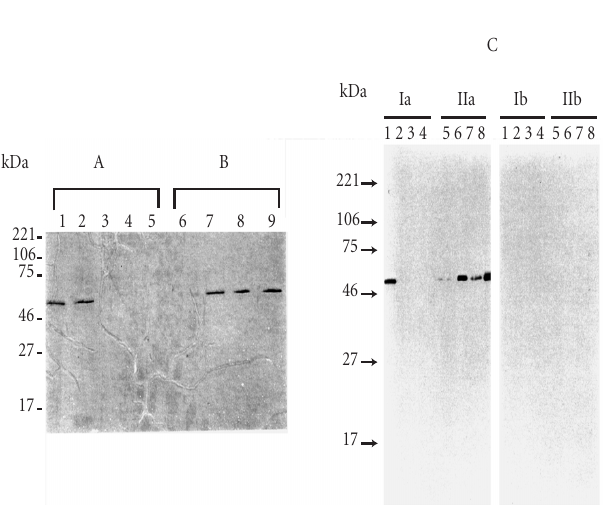
Figure 1: (A) Elution profiles of T. cruzi Tc52-bound to S-hexyl glutathione columns with either S-hexyl glutathione (1) or the fol- lowing amino acids: L-cysteine (2), L-methionine (3), L-glycine (4), glutamic acid (5). (B) After elution as described in A, the columns from which the eluates analysed in lanes 2, 3, 4, and 5 were recov- ered, washed with the column buffer, and loaded with the same buffer containing S-hexyl glutathione, the corresponding eluates were analysed in lanes 6, 7, 8, and 9, respectively. As shown in lane 6, residual Tc52 could be recovered from the column which was first loaded with L-cysteine (lane 2). In contrast, Tc52 which still bound to the glutathione matrix after the elution with L-methionine (3), L-glycine (4) or Glutamic acid (5), could be efficiently eluted by S-hexyl glutathione (lanes 7, 8, 9, respectively). (C) Aliquots of the eluted samples in A (Ia) and B (IIa) (the lanes 1, 2, 3, 4, 5, 6, 7, and 8, corresponded to the products eluted and analyzed in lanes 2, 3, 4, 5, 6, 7, and 9, respectively), were separated by SDS-PAGE, trans- ferred to nitrocellulose filters and probed using a rabbit immune serum to Tc52 fusion protein (cDNA encoding the Tc52 protein, initially named TcAc2, was subcloned in pGEX-2T vector, and the protein was produced in fusion with Schistosoma japonicum 26 kDa glutathione S-transferase (Tc52-Sj26GST)). The fusion protein and the corresponding antibodies were obtained as described in a pre- vious report [10]. Ib and IIb represent control tests using samples analysed in Ia and IIa, respectively, and treated with anti-Sj26GST rabbit serum. Methods: T. cruzi (Y strain) epimastigotes were maintained in cul- turemediumasdescribedin[10].Parasitesolubleantigenswerepre- pared and adjusted to 5mg proteins/ml in buffer (20mM HEPES, pH 7.25, 1mM EDTA, O.15M KCl supplemented with 0.5mM final concentration of PMSF), and passed through S-hexyl glutathione affinity matrix. The column was then washed with 30ml of the same buffer, bound material was eluted using 20ml of buffer con- taining 2.5mM S-hexyl glutathione (1), or 1mg/ml of either of the following amino acids: L-cysteine (2), L-methionine (3), L-glycine (4), or L-glutamic acid (5). The columns corresponding to the lanes 2, 3, 4, and 5 were extensively washed with buffer and loaded with 20ml of buffer containing 2.5mM S-hexyl glutathione. All the elu- atesweredialysedagainstdistilledwaterandanalysedbySDS-PAGE. The proteins were visualized using the silver staining